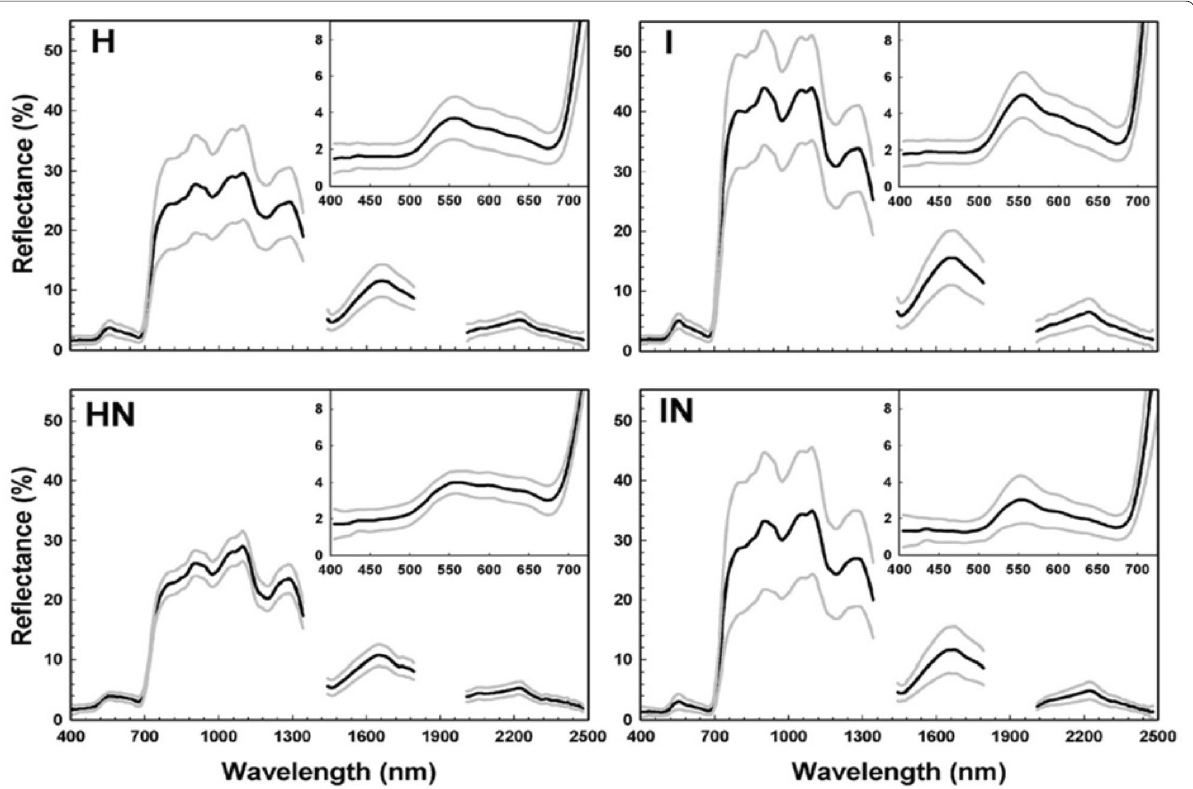
Fig. 2 Mean ( S.D.) spectral reflectance of Invasive (I), native Hawaiian non-nitrogen-fixer (H), and native nitrogen-fixer (HN), and invasive nitrogen ± fixer (IN) species (Asner et al. 2008). It clearly describes the spectral separability of invasive and native species and the role of remote sensing in its identification is very